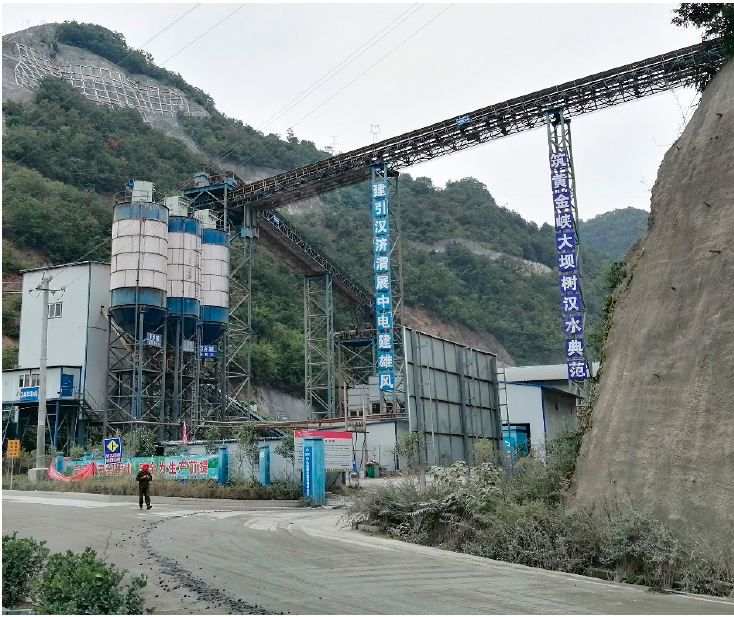
Figure 5. Huangjinxia mixing plant.